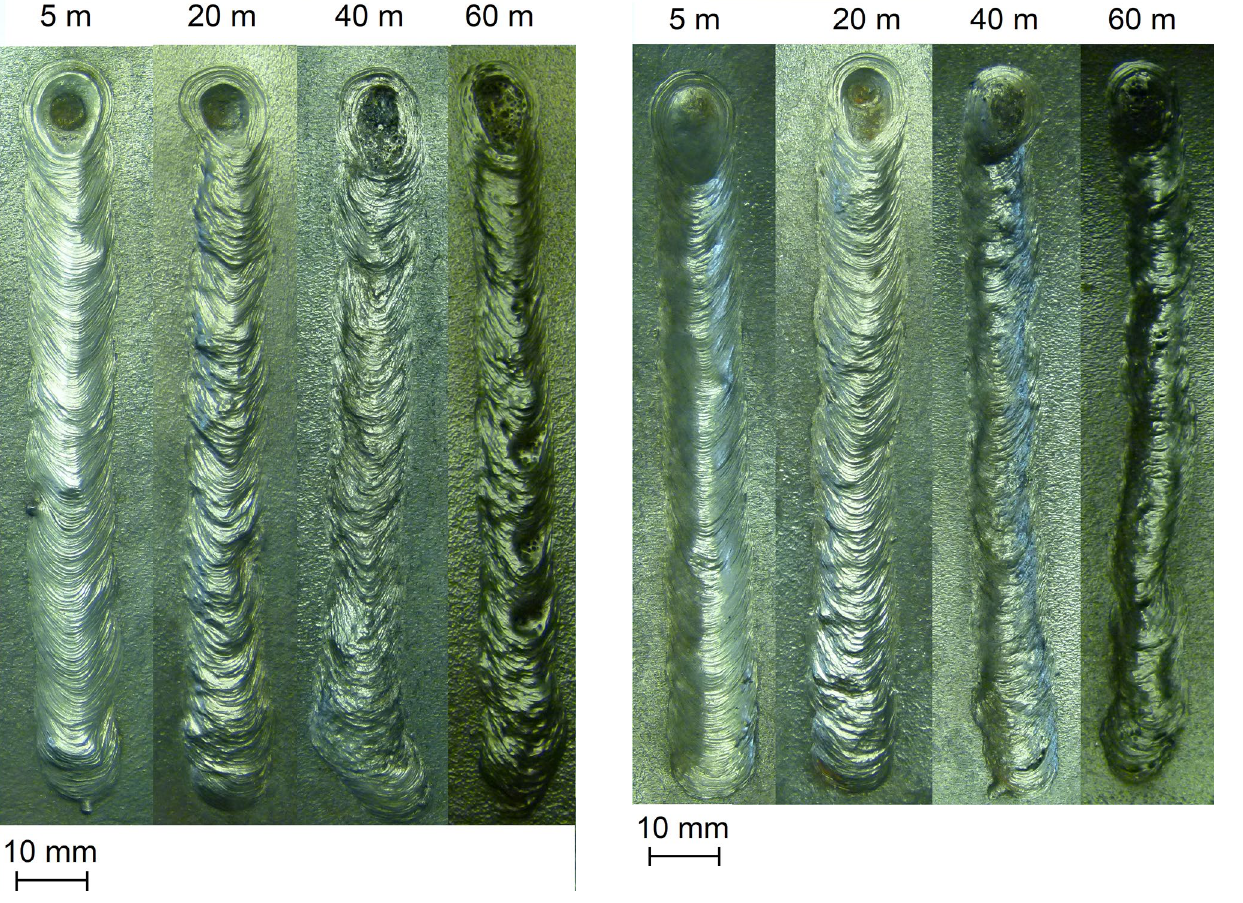
Fig. 11 Bead on plate weld seams welded with the stick electrode HK6 in the water depth 5 m, 20 m, 40 m, and 60 m. The parameters used are listed in Table 2